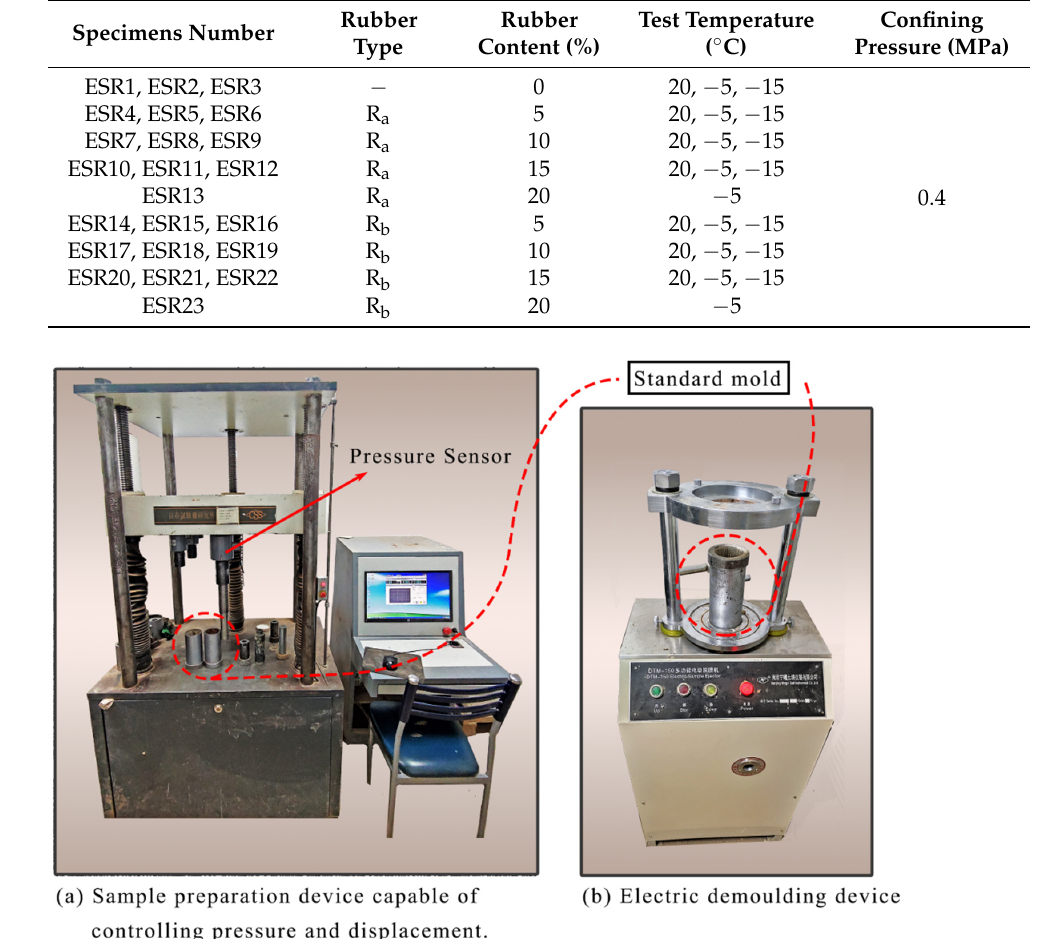
Figure 3. Standard specimens auto-preparation device and specimens auto-release machine. ( a ) Specimens preparation machines. ( b ) Mold release machine.